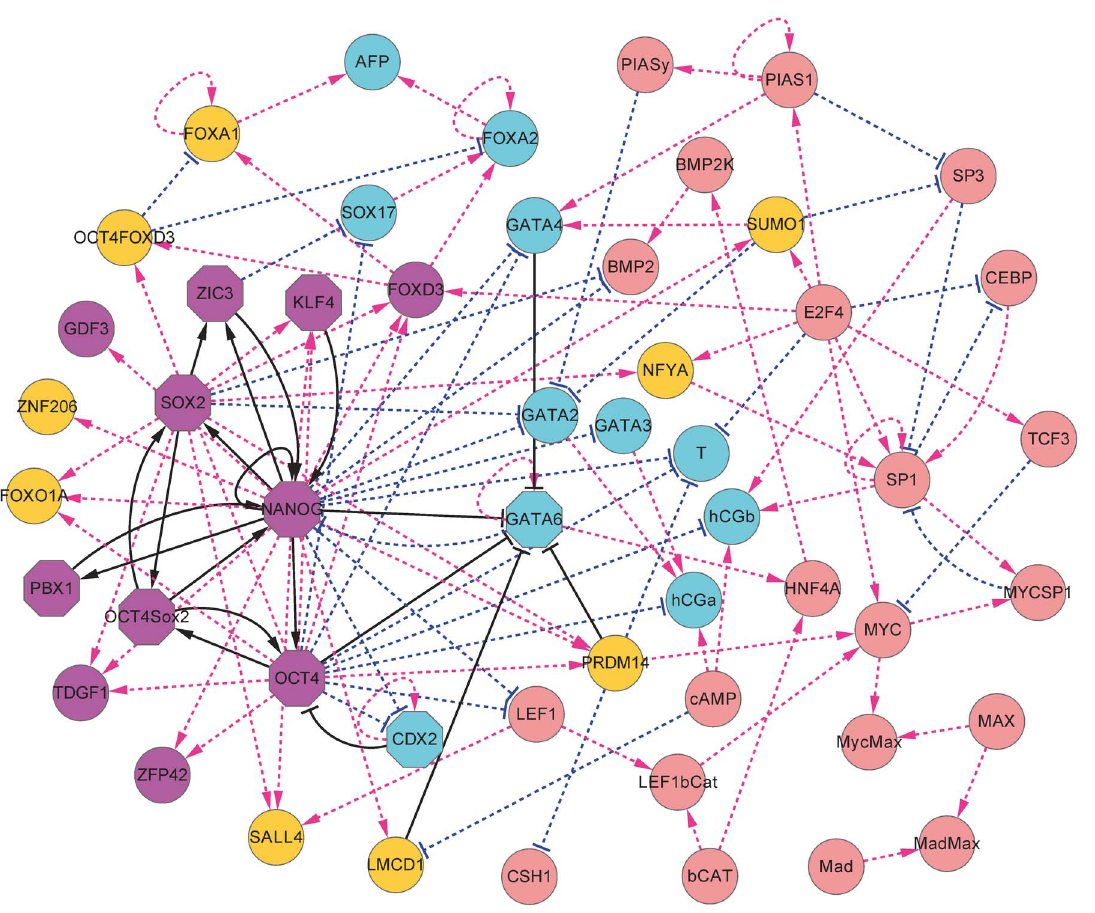
Figure 1. The diagram for the stem cell developmental network including 52 gene nodes and their interactions (arrows represent activation and perpendicular bars represent repression). The magenta node represent 11 marker genes for the pluripotent stem cell state, cyan nodes represent 11 marker genes for the differentiation state, and the yellow nodes represent genes activated by the stem cell marker genes. The solid black links represent the key links found by the global sensitivity analysis, and the octagon shape nodes represent key stem cell and differentiation markers found by global sensitivity analysis.